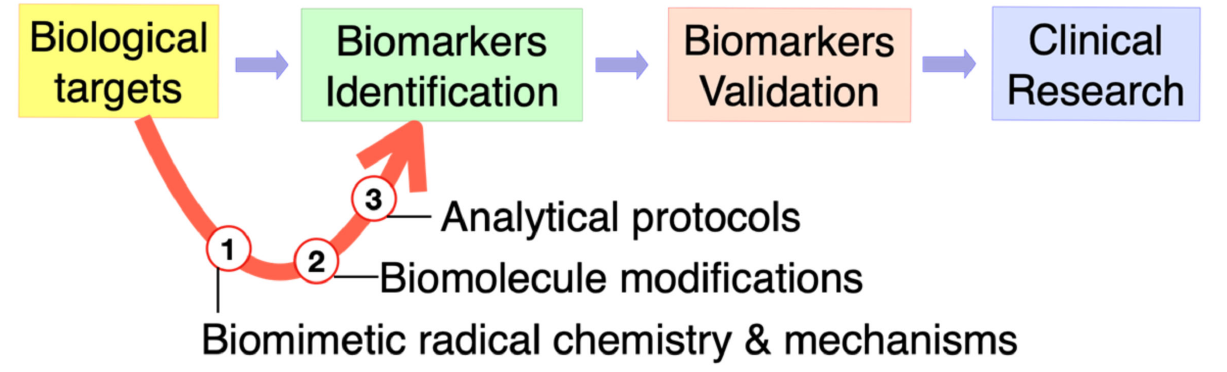
Figure 1. Omics technologies and the role of biomimetic radical chemistry in biomarkers